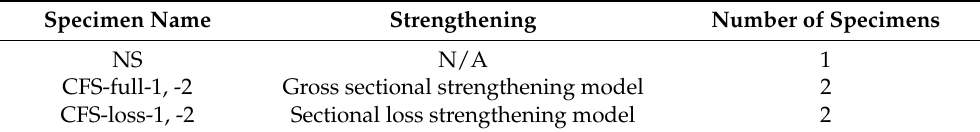
Table 2. Experimental parameters.